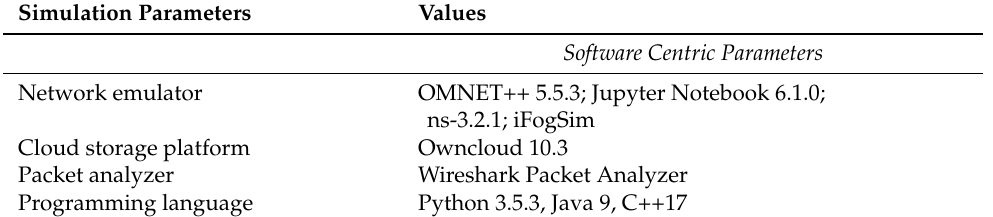
Table 5. Parameters of the simulation environment (software centric).